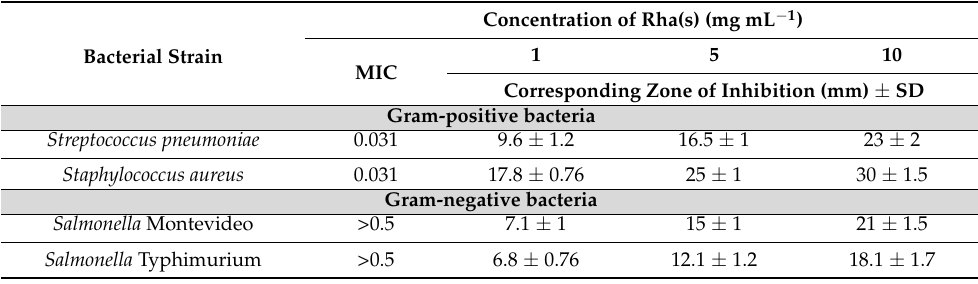
Table 3. The antimicrobial activity of rhamnolipids nano-micelles was presented as average ± standard deviation. Results are average of two independent experiments with three replicates in each.